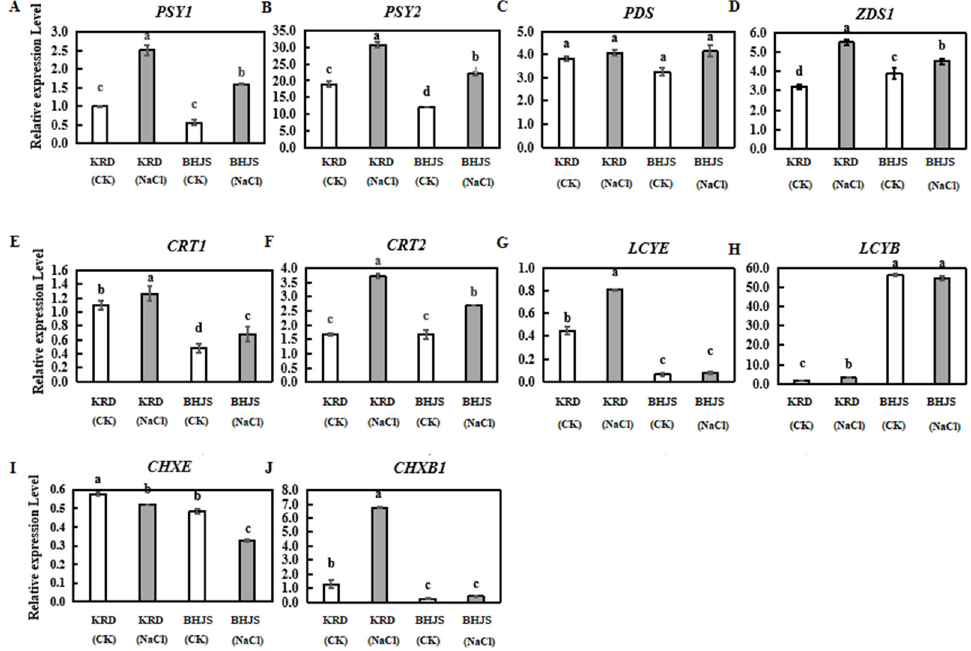
Figure 5. Relative expression levels of carotenoid biosynthesis-related genes under salt stress. ( A ) Relative expression level of PSY1 in the roots of ‘BHJS’ and ‘KRD’ under different treatment; ( B ) PSY2 ; ( C ) PDS ; ( D ) ZDS1 ; ( E ) CRT1 ; ( F ) CRT2 ; ( G ) LCYE ; ( H ) LCYB ; ( I ) CHXE ; ( J ) CHXB1 . Different lowercase letters indicate significant differences among different carrot cultivars and treatment at the p < 0.05 level.